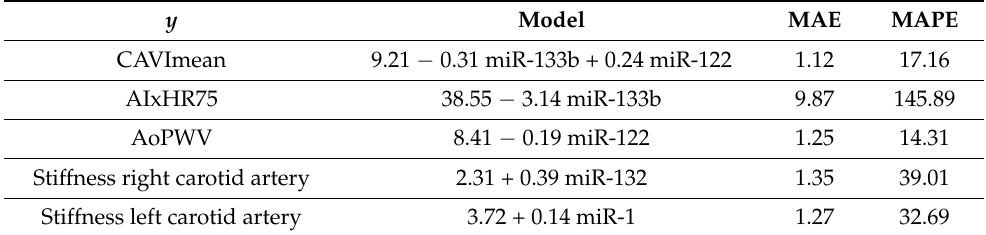
Table 4. Linear regression